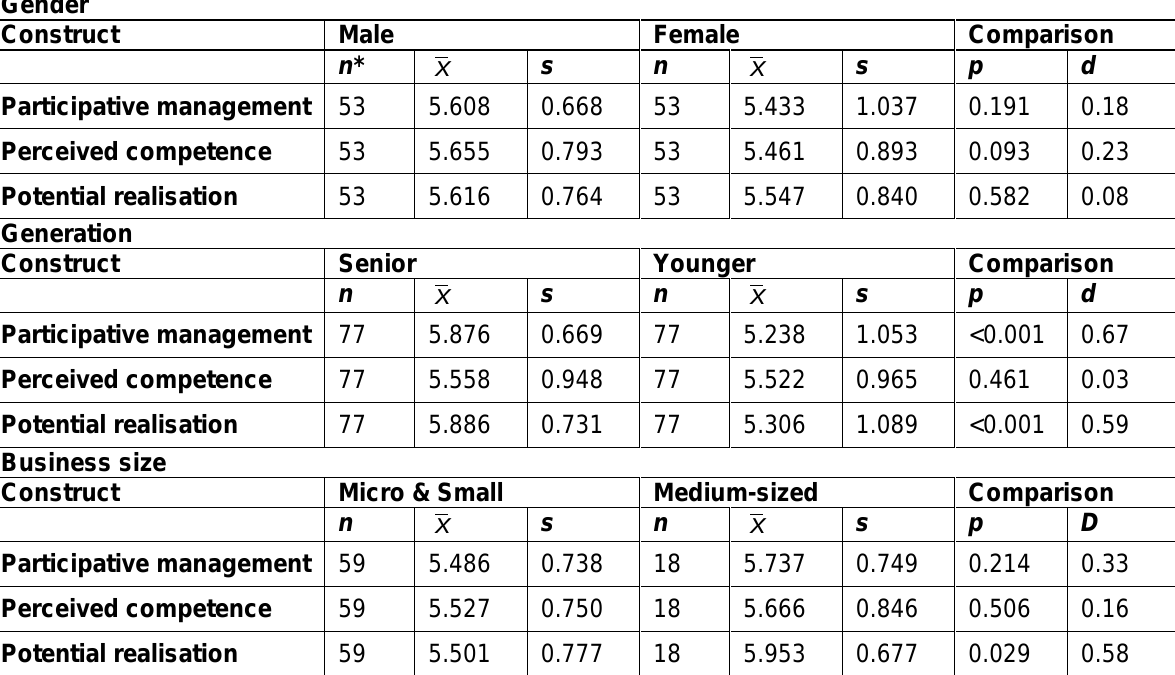
Table 3: The results of the differences in means between the constructs for different demographic